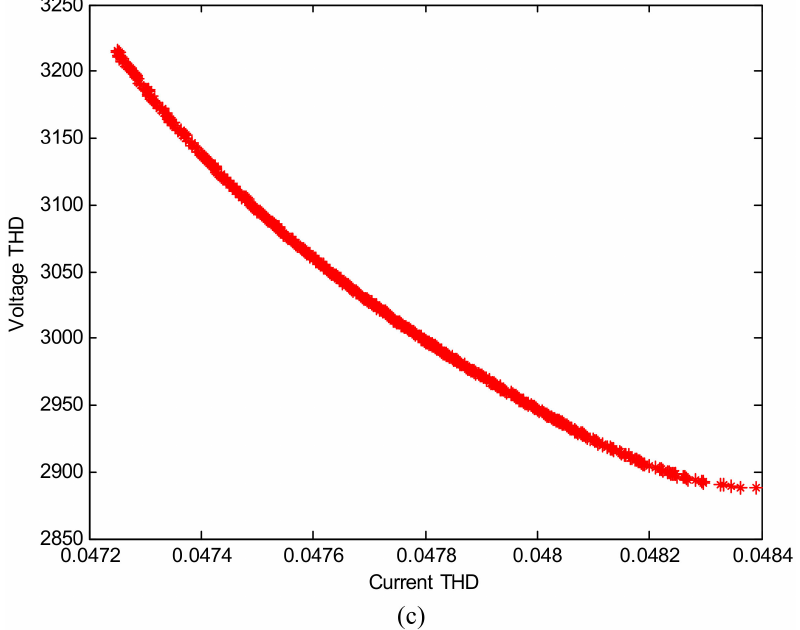
Figure 4. Pareto front obtained by ( a ) sub-group search strategy, ( b ) without sub-group search strategy, and ( c ) Monte Carlo